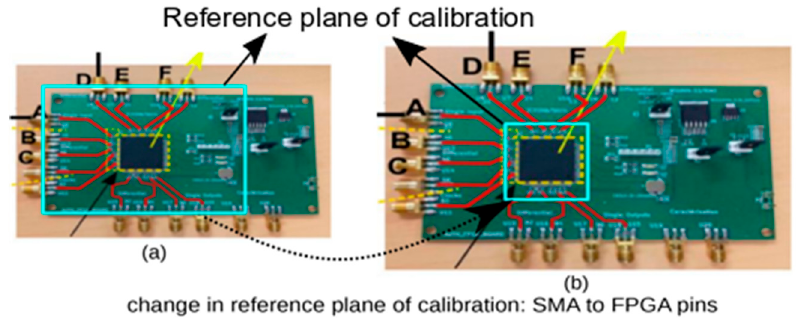
Figure 9. Changing reference plane of calibration. ( a ) Technique using difference of two routes to remove the systematic error relating to the PCB board. ( b ) Description of implementing the difference approach on the response of two routes of the FPGA.